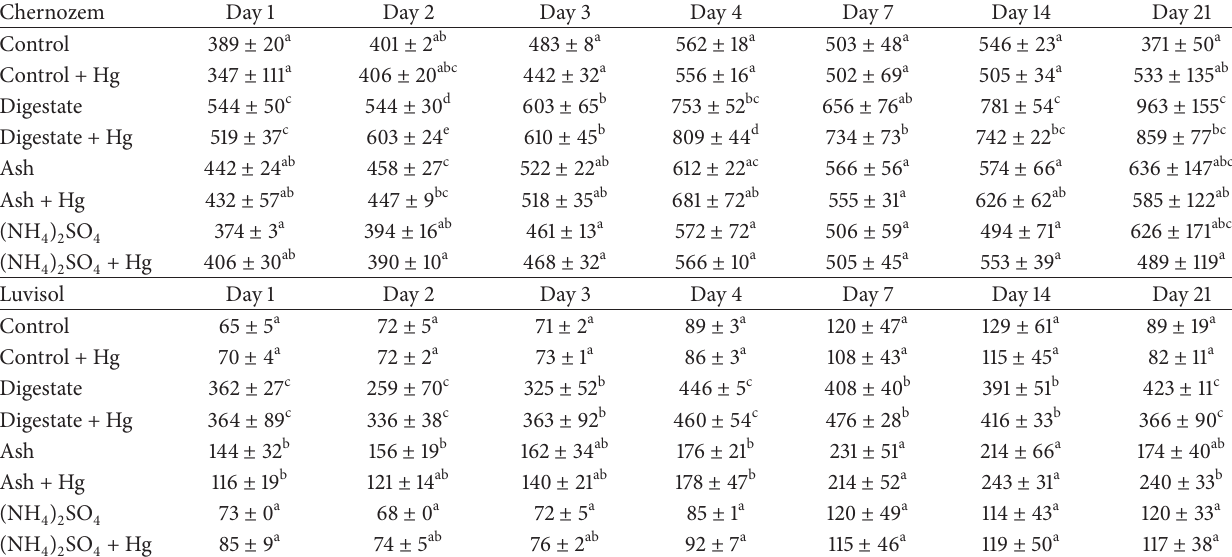
Table 4: The concentrations of Mg extractable with 0.11 molL − 1 acetic acid within the incubation experiment (mg ⋅ kg − 1 ); the averages marked by the same letter did not significantly differ at 𝑃 < 0.05 within individual columns; data are presented as mean ± standard deviation ( 𝑛 = 3